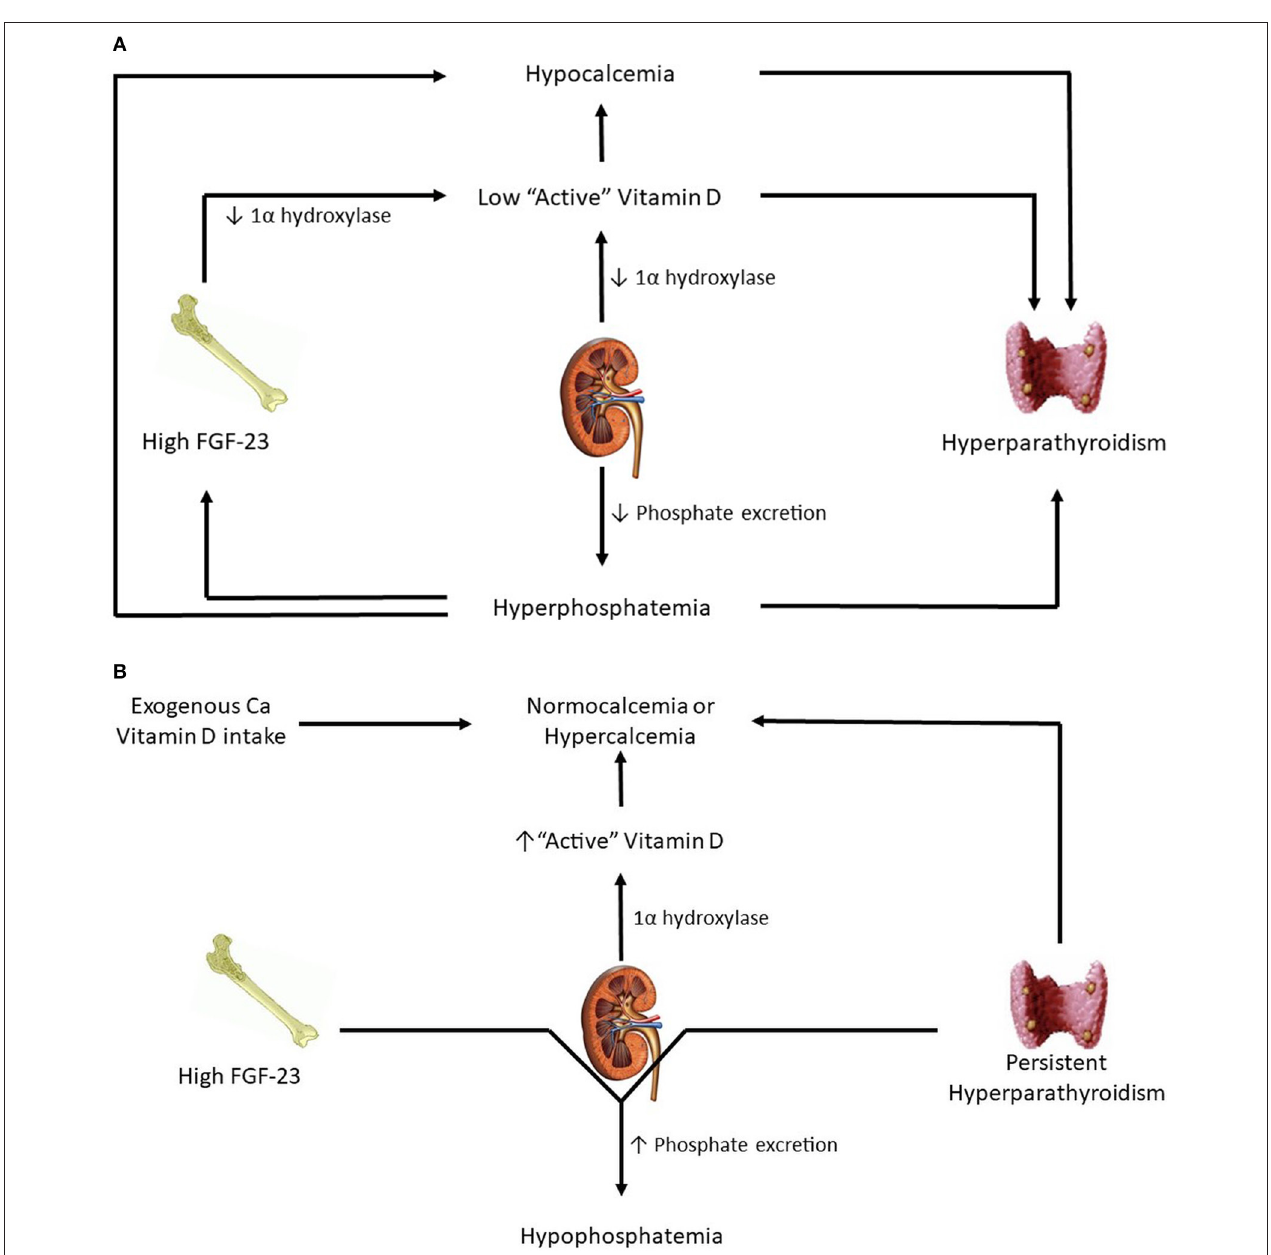
FIGURE 1 | (A) Patients in advanced kidney disease. (B) Changes in kidney transplant patients with good allograft